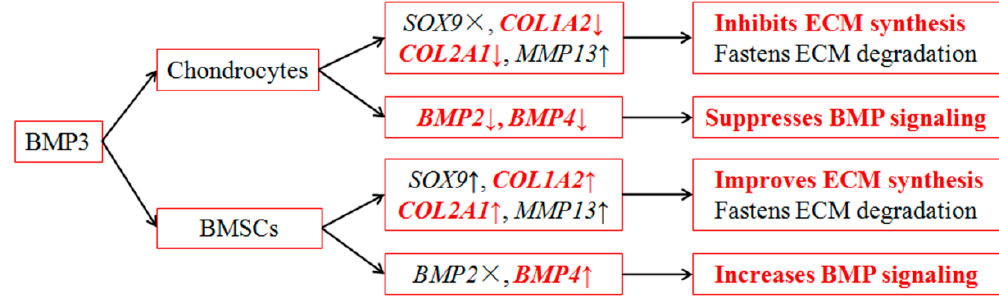
Figure 7. The functions of BMP3 between chondrocyte and BMSCs. ×, ↑ , ↓ stand for no up-regulate, down-regulate, effect, up-regulate, down-regulate, respectively.